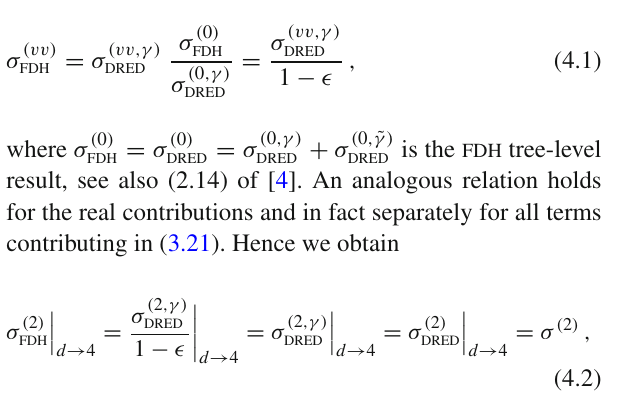
Fig. 2 Double-real contributions that require special treatment in fdh to correct for unitarity violations. The blob represents either a quark, a gluon, or a ghost